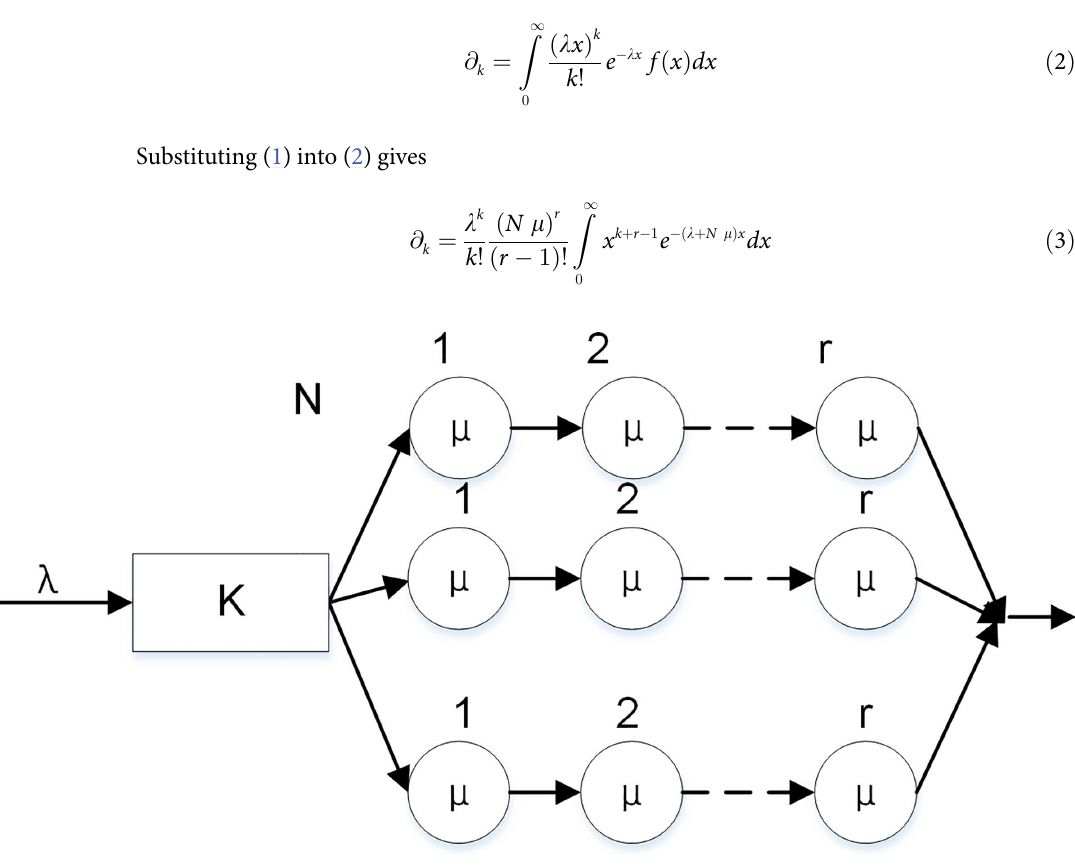
Fig 2. Single layer of the ALF